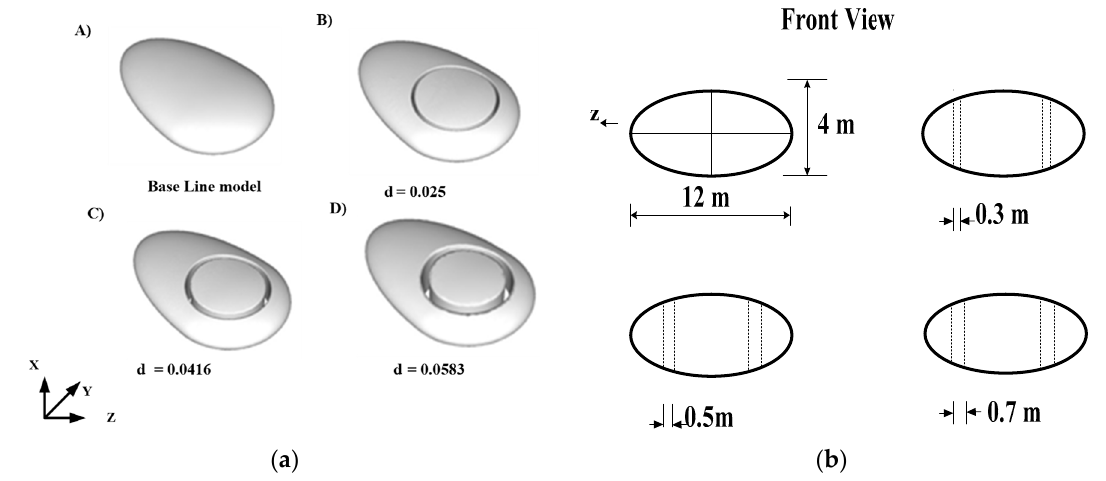
Figure 2. ( a ) Hybrid airship shape with circular slot openings with three different thicknesses; ( b ) corresponding front view.